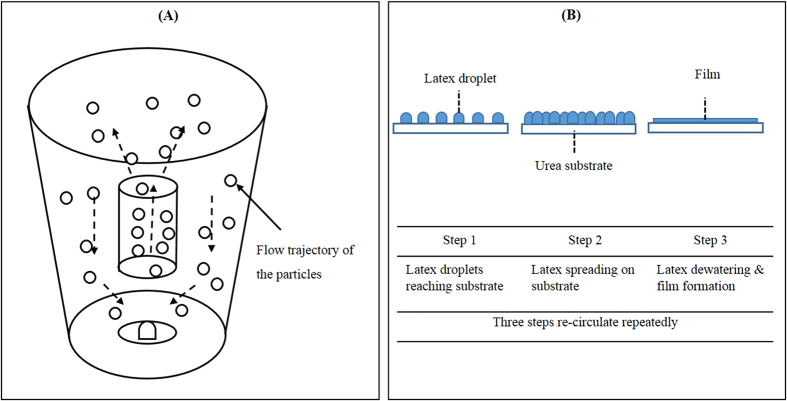
Schematic of the spray coating process in a Wurster fluidized bed12
(A) and film formation in the spray coating process22
(B).